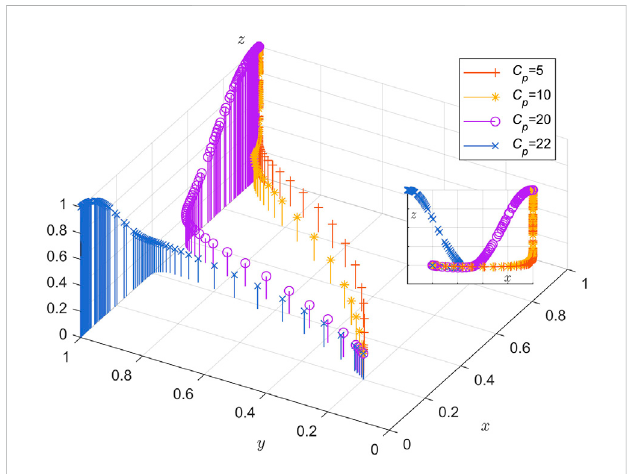
FIGURE 10 Impact of cost Cp on stakeholder behavior